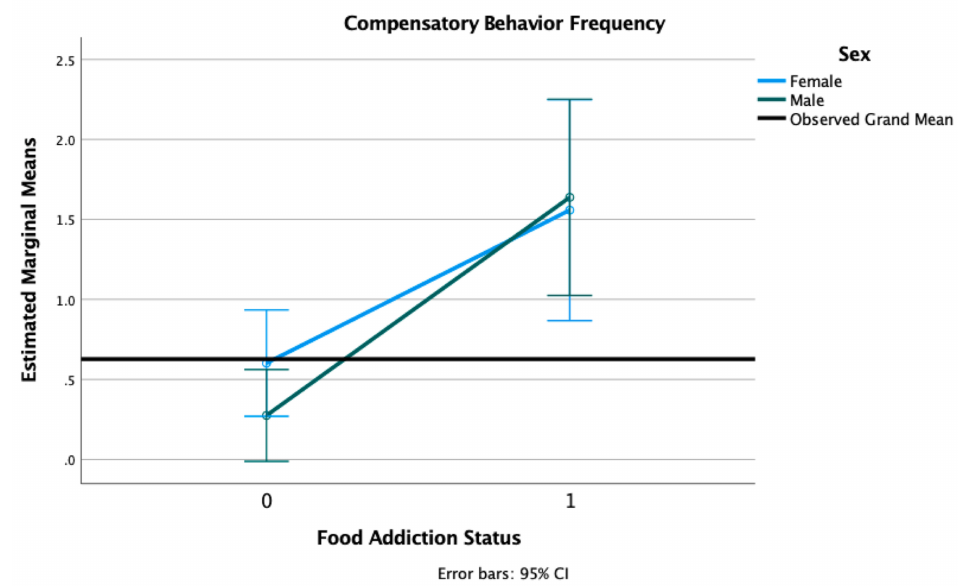
Figure 3. Estimated marginal means of compensatory behaviors frequency for a 2 × 2 factorial ANOVA with sex (female, male) and FA status (1 = positive, 0 = negative, on the X -axis) adjusted for age, race, and PTSD status (threshold vs. subthreshold).